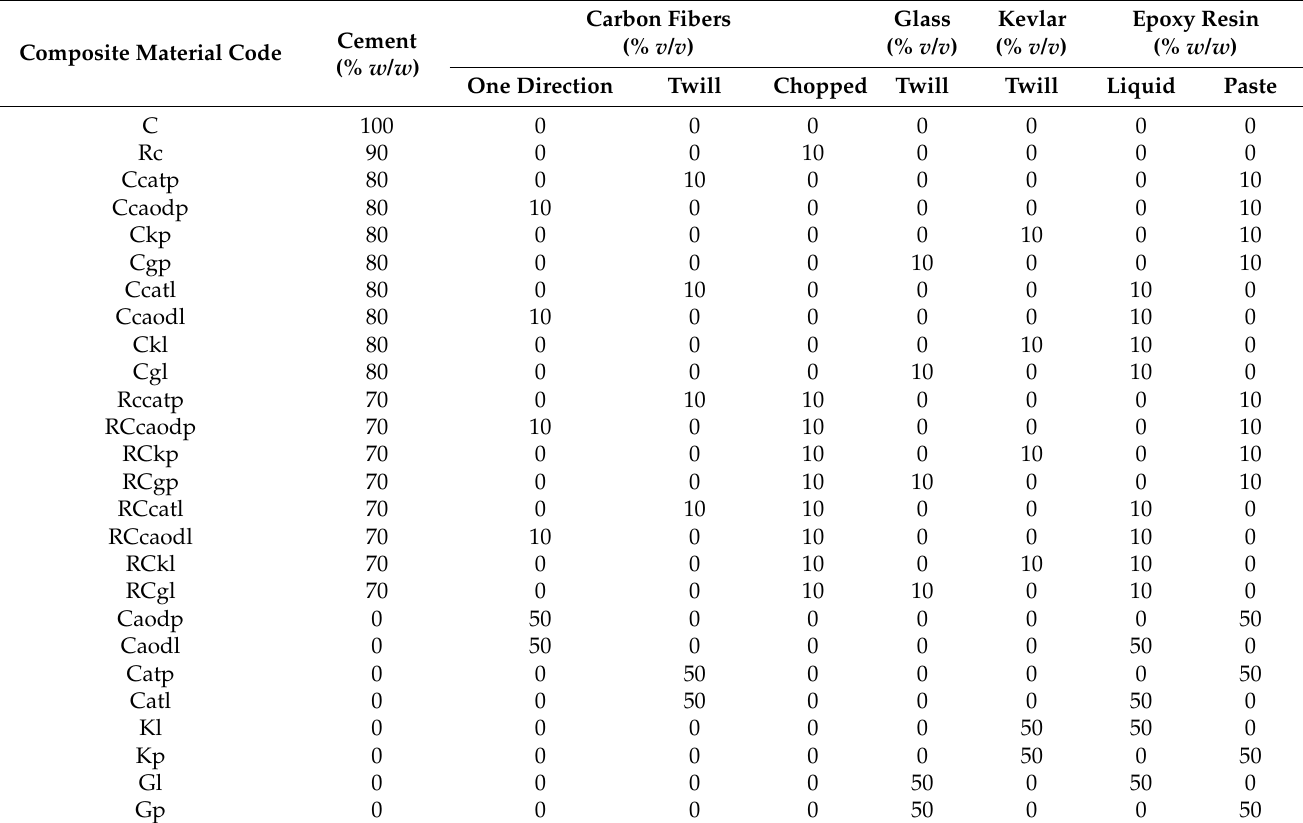
Table 1. Composite materials of epoxy resin–carbon fiber and cement